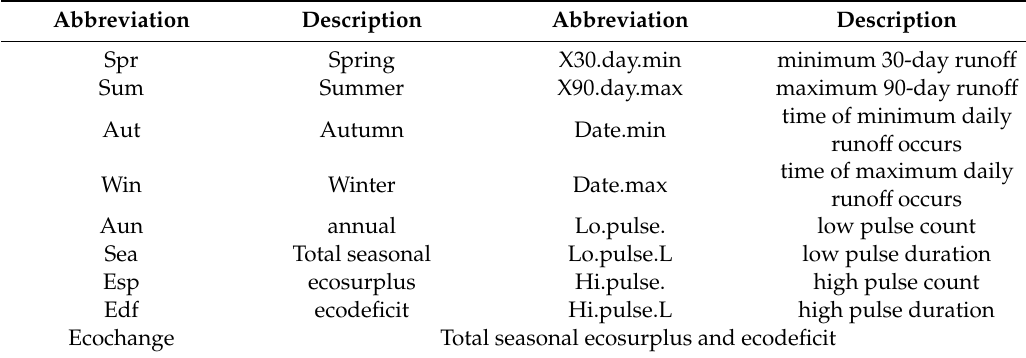
Figure 7. Heat maps of correlations between the IHA-32 indexes and eco-flow metrics. The information of the abbreviations in the figure is shown in Table 7. Table 7. The descriptions of abbreviations used in Figure